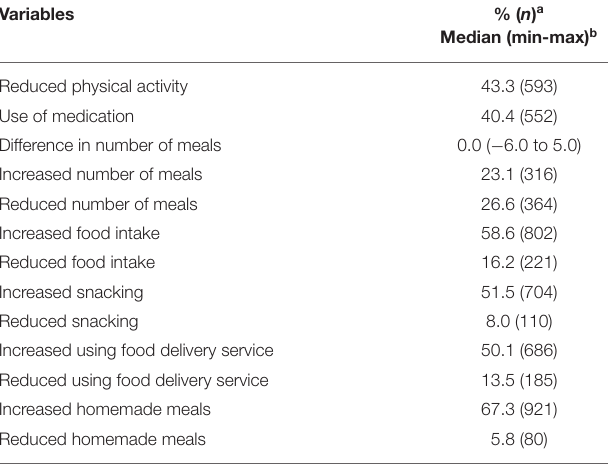
TABLE 1 | Socioeconomic factors, lifestyle, and eating habits of a Brazilian sample during the COVID-19 pandemic